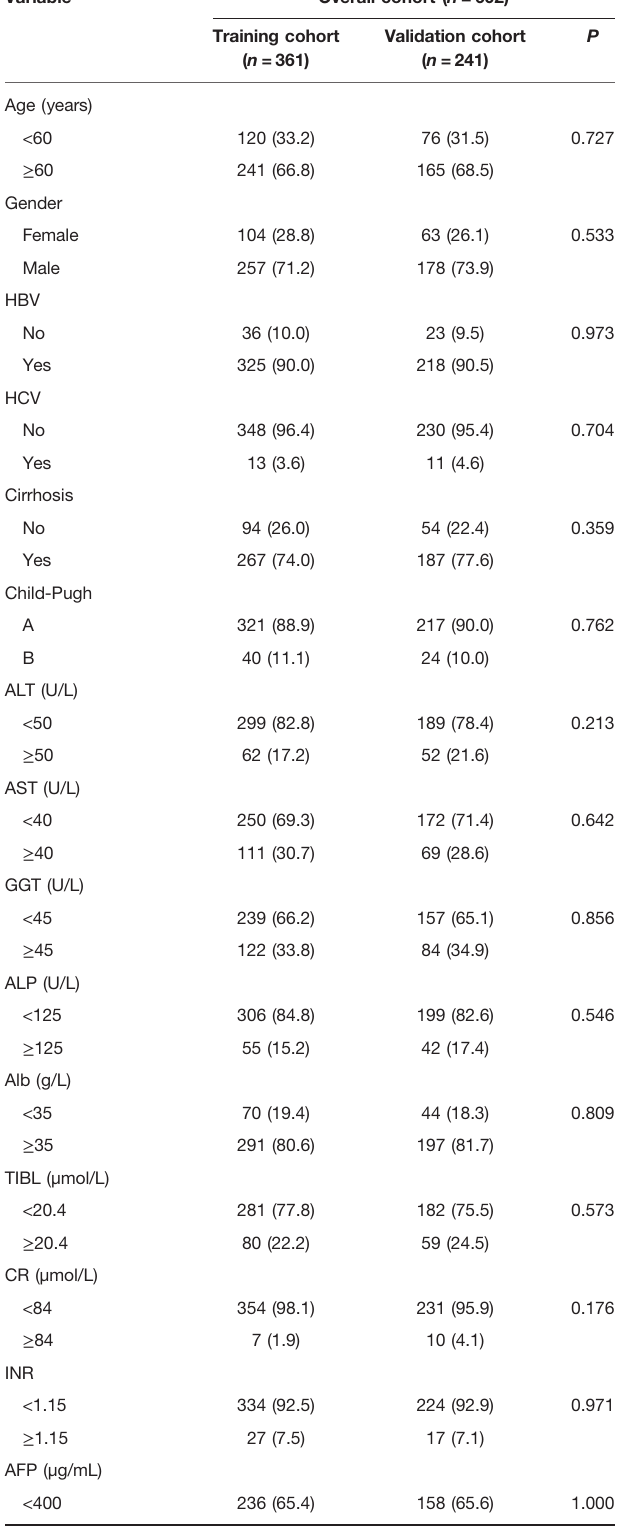
TABLE 1 | Comparison of clinicopathological variables between Training cohort and Validation cohort. Variable